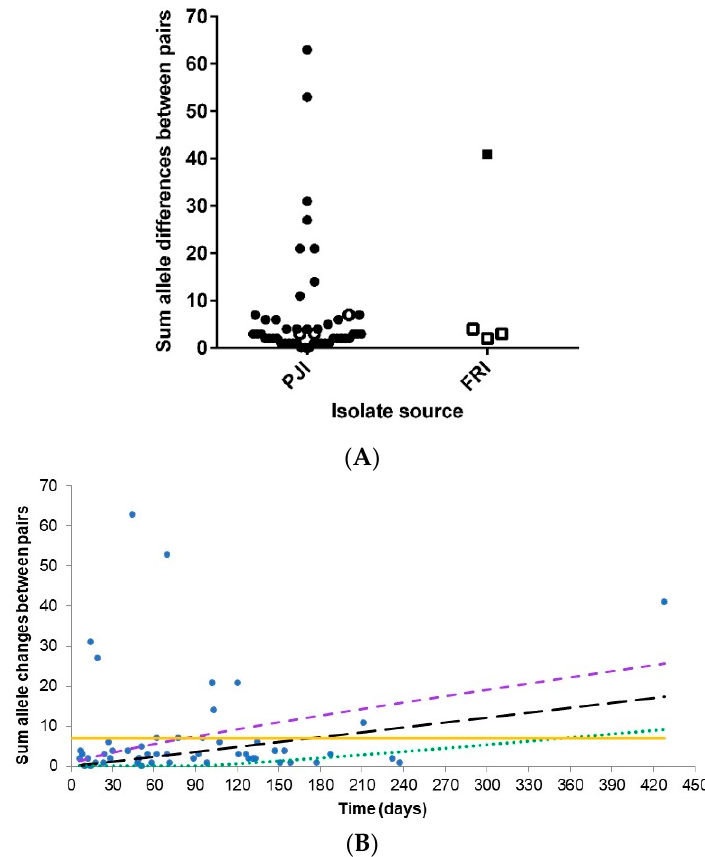
Figure 3. Molecular diversity among 102 isolates from 49 patients, ( A ) graph showing the sum of allele differences in 710 core genes; ( B ) frequency distribution of allele differences between observed values (blue dots) and expected values (black hash line) against time between isolate pairs as determined by Poisson distribution analysis. Purple hash line: upper limit (95% CI), green dotted line: lower limit (95% CI), and yellow line: signifies 7 allele differences.